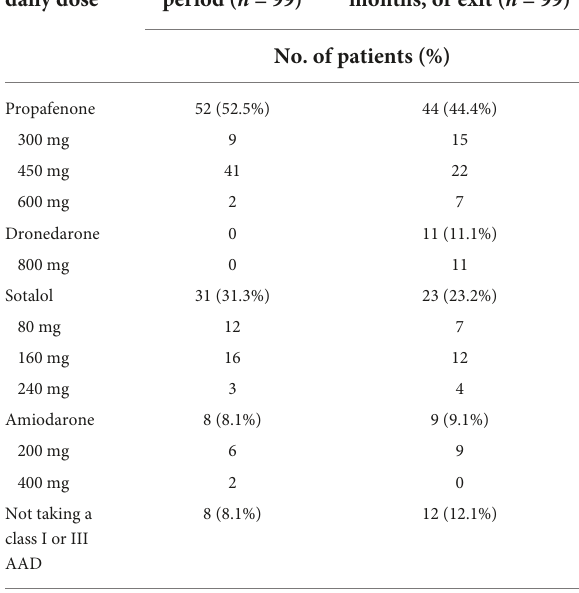
TABLE 2 AAD therapy and dosing in the AAD